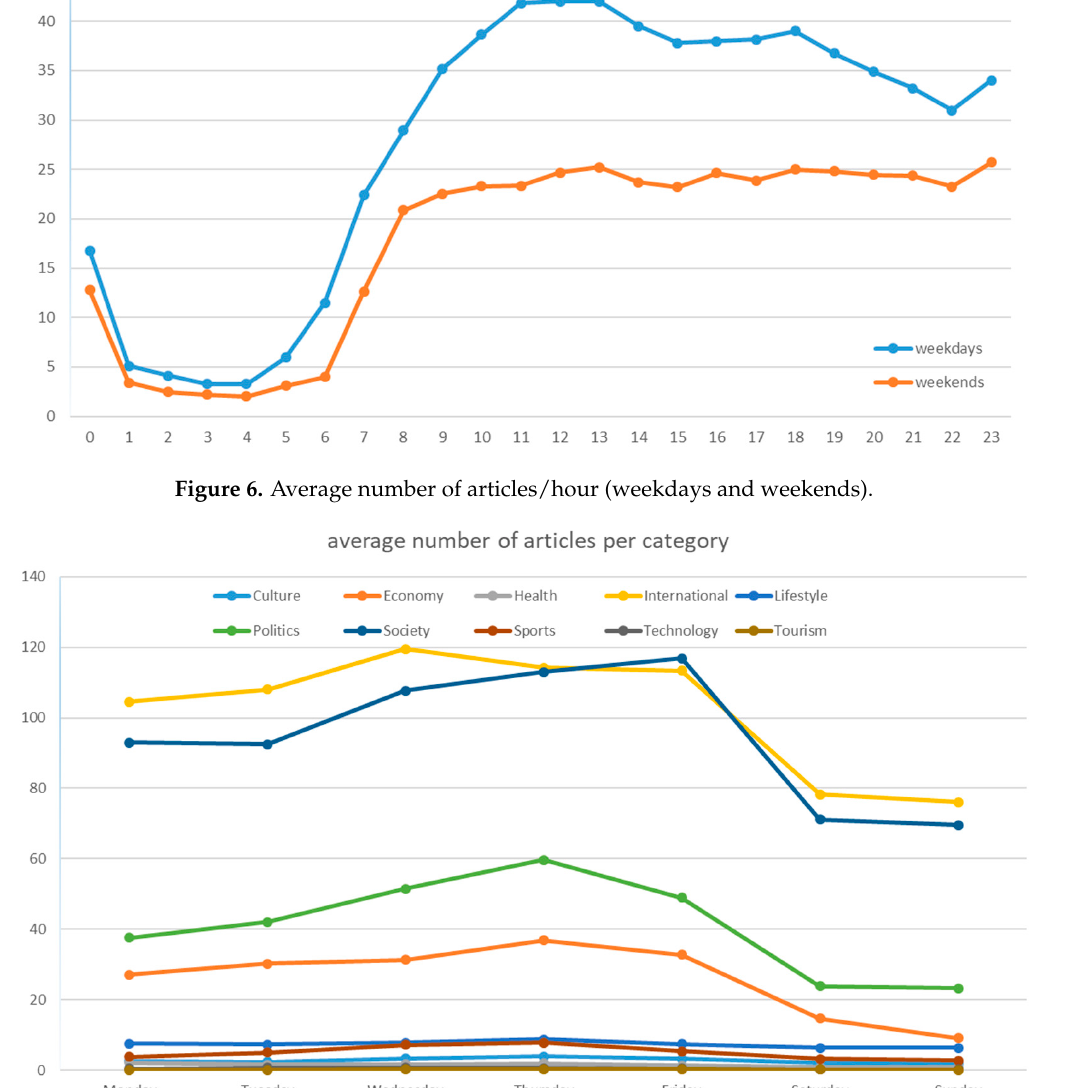
Figure 7. Average number of articles per category/day.